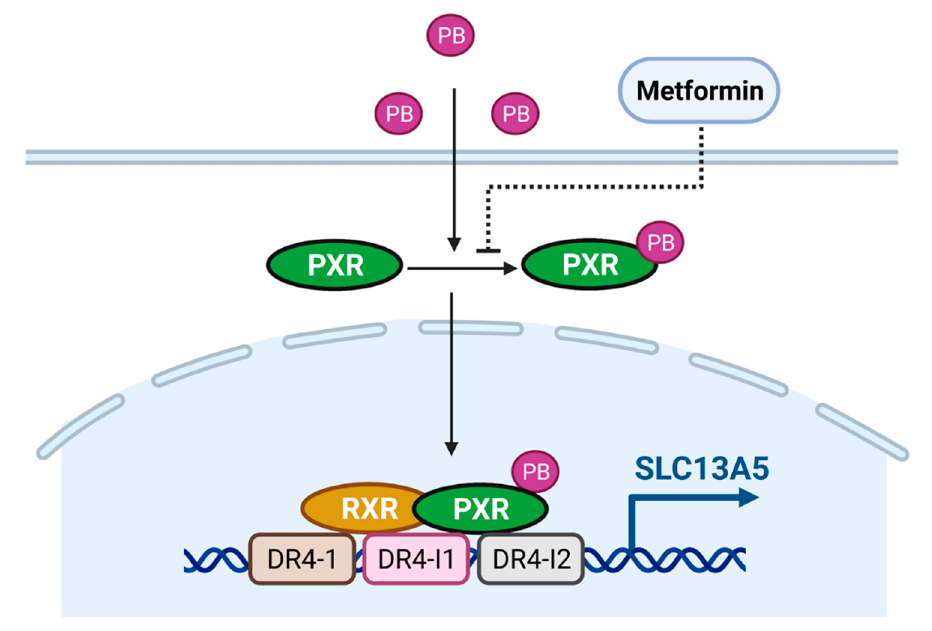
Figure 7. Schematic illustration of PB as an inducer of SLC13A5 through activation of human PXR. PB is a ligand of human PXR, which translocates PXR from the cytosol to the nucleus of human hepatocytes. Once inside the nucleus, PXR and RXR form a heterodimer that binds to the upstream DR4-1, intron DR4-I1, and DR4-I2, and stimulates the SLC13A5 gene transcription.